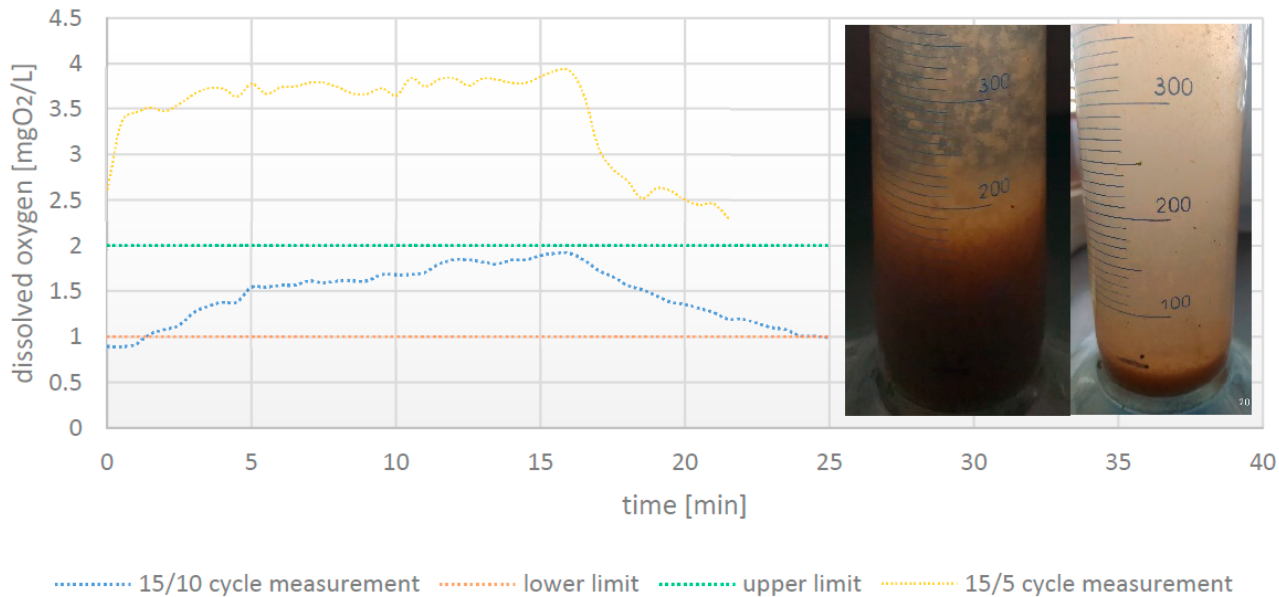
Figure 2. The course of dissolved oxygen concentration in activated sludge chamber in different aeration/resting cycles. Photos of sludge during sedimentation ( left : 15/10 min cycle; right 15/5 min cycle).